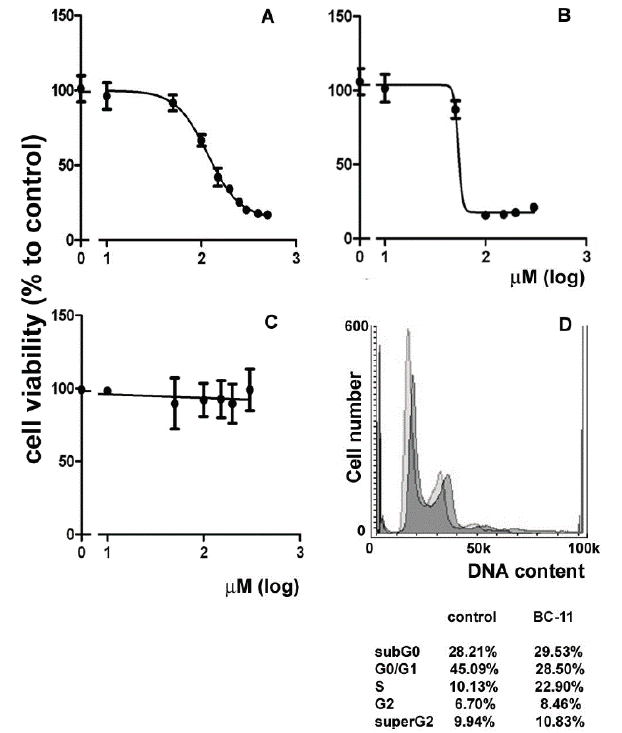
Figure 2. Effect of the different compounds on the viability of MDA-MB231 cells and of the exposure to BC-11 at its ED 50 at 72 h on cell cycle. Dose-response curve for MDA-MB231 cell viability after treatment with ( A ) BC-11; ( B ) doxorubicin and ( C ) 1 for 72 h. The ED 50 of BC-11 and doxorubicin are 117 and 80 μ M, respectively. The ED 75 of BC-11 is 250 μ M. Error bars correspond to s.e.m. of three independent measurements; ( D ) DNA profiles of MDA-MB231 cells after 72 h of culture in control conditions (lighter in the background) and in the presence of 117 μ M BC-11 (darker superimposed). Total cell distribution is reported in the annexed